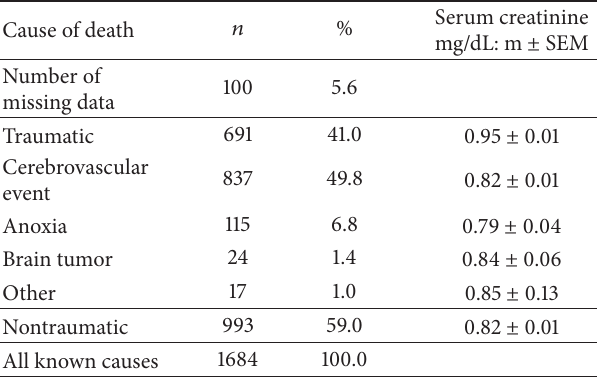
Table 3: Relationship between donor’s cause of death and terminal serum